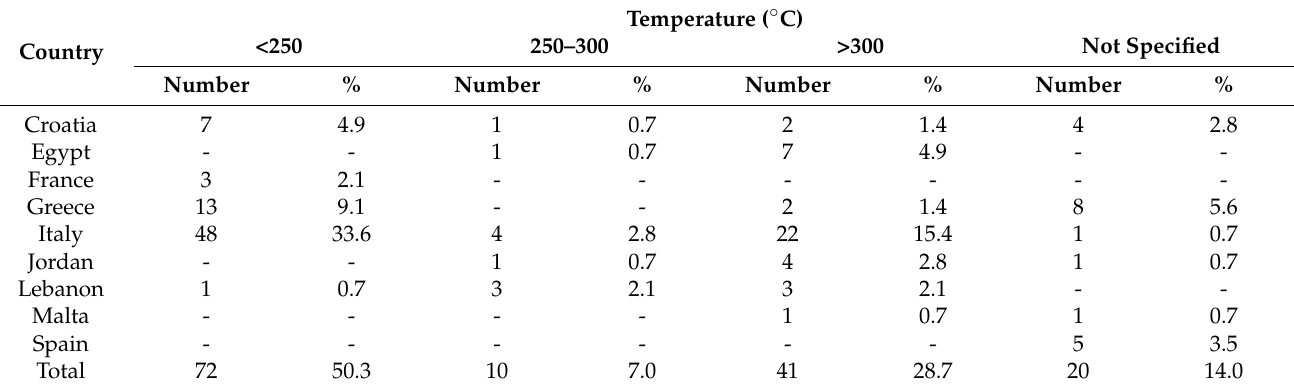
Table 6. Baking temperature adopted in the baking process of flat